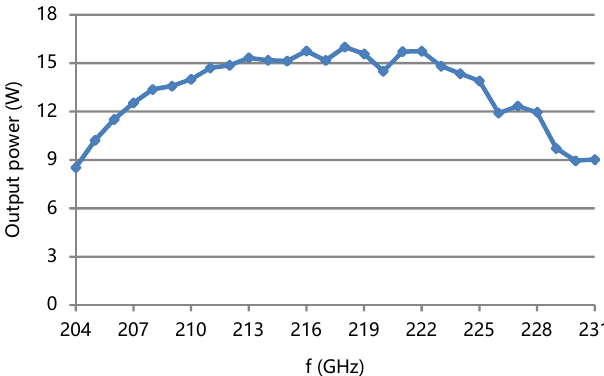
The measured saturation output power and gain of the TWT are shown in Figures 18 and 19. The saturation output power is over 8 W and the saturation gain is over 30.5 dB in 204–231 GHz. The saturation output power is over 10 W in 205–228 GHz. The maxi- mum output power is 16 W at 218 GHz. The 3 dB bandwidth is greater than 12.3% of f c . The gain ripple is less than 10 dB in band.